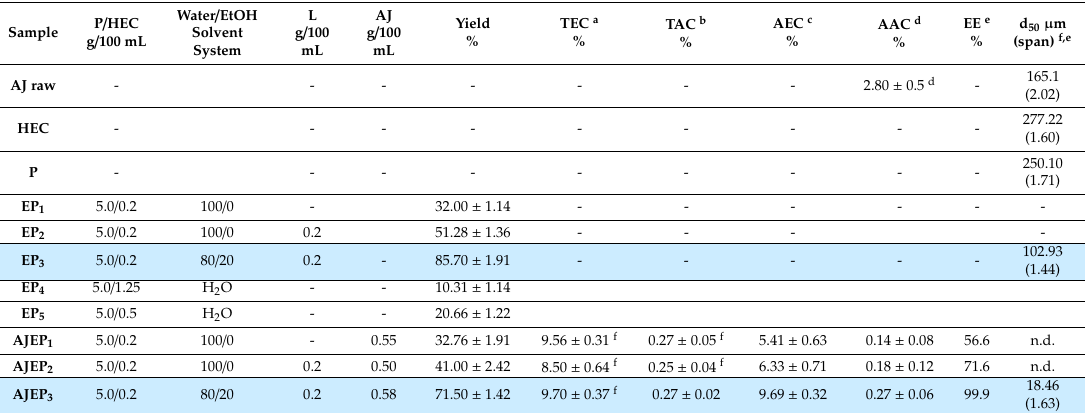
Table 1. Composition and characteristics of raw materials and spray-drying